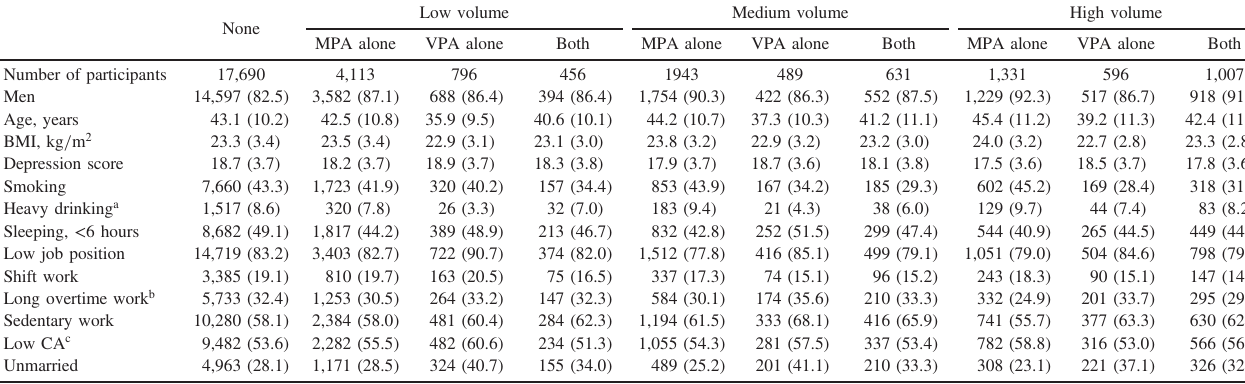
Table 1. Baseline characteristics of participants by intensity and volume of leisure-time exercise None